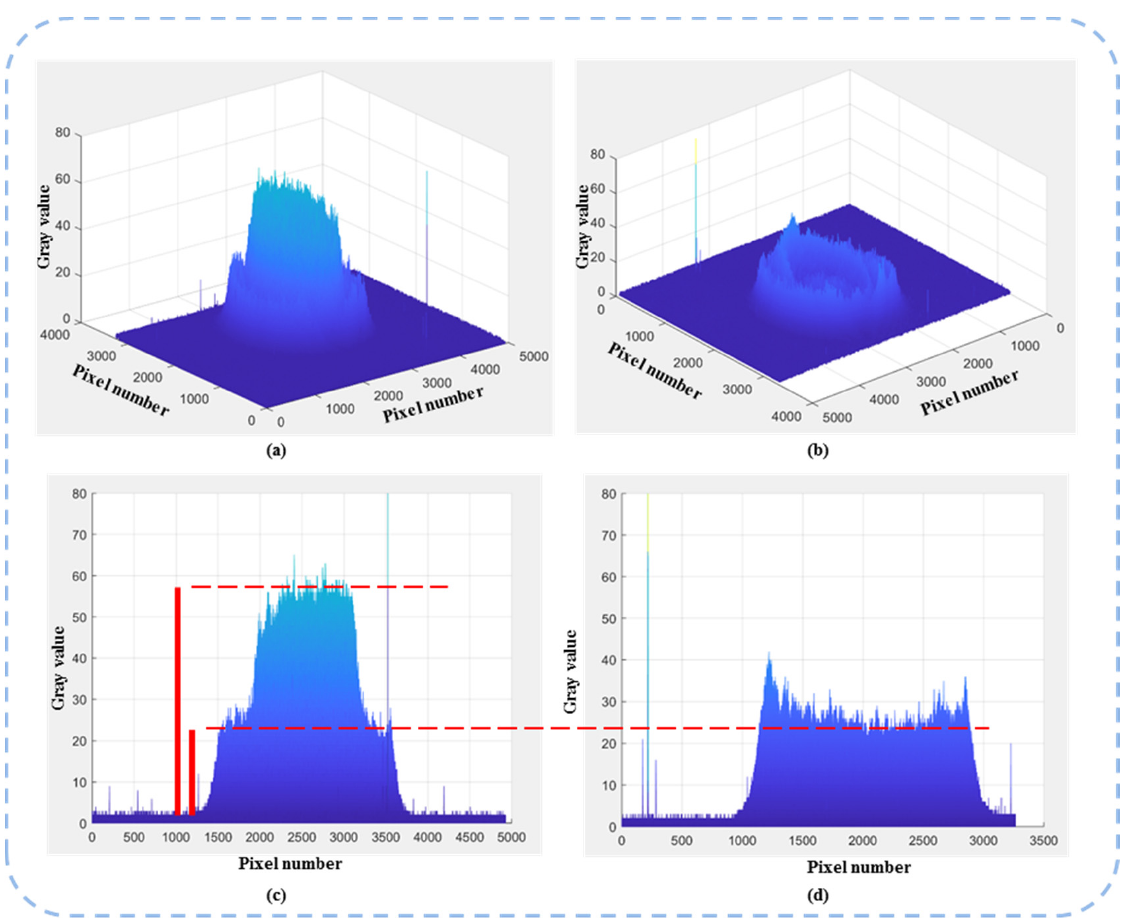
Figure 15. The 3D plots of the intensity of images provide a comparison of the overlapped area and area of input beams under an analyzer at 45°. ( a , b ) and ( c,d ) show the corresponding 3D intensity and 2D intensity,